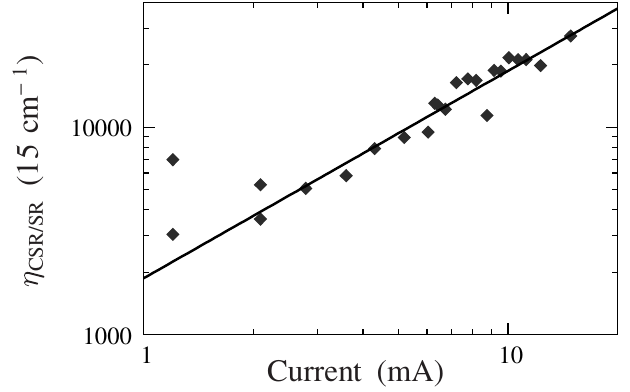
FIG. 9. Ratio between CSR and incoherent SR terahertz en- ergy per pulse and unit bandwidth, at the modulation frequency ( 15 cm (cid:1) 1 ). Squares: experimental data; full line: linear fit. Incident laser pulse energy: 800 (cid:1) J